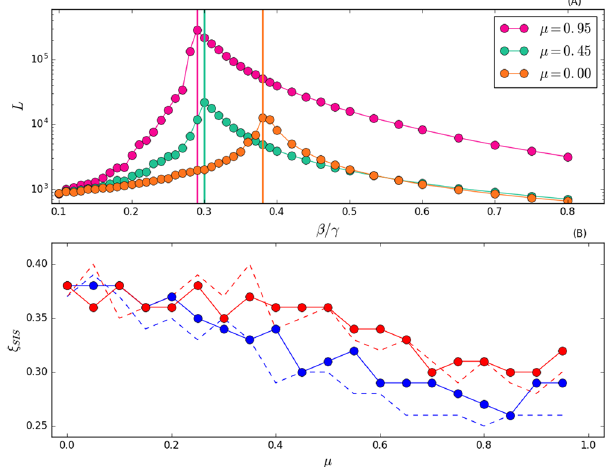
Figure 5. Panel (A) Lifetime of the disease L as a function of β / γ , for selected values of μ and when s min = 10. Vertical lines are the epidemic threshold. Panel (B) Ratio ξ SIS = β / γ in correspondence of L max , as a function of = 100, blue curves s = 10. Each point is an average of 10 2 independent simulations. μ . In red curves we set s min min Note that we avoid to simulate μ = 1 because the criterion we follow for the estimation of the threshold does not hold for a network with many connected